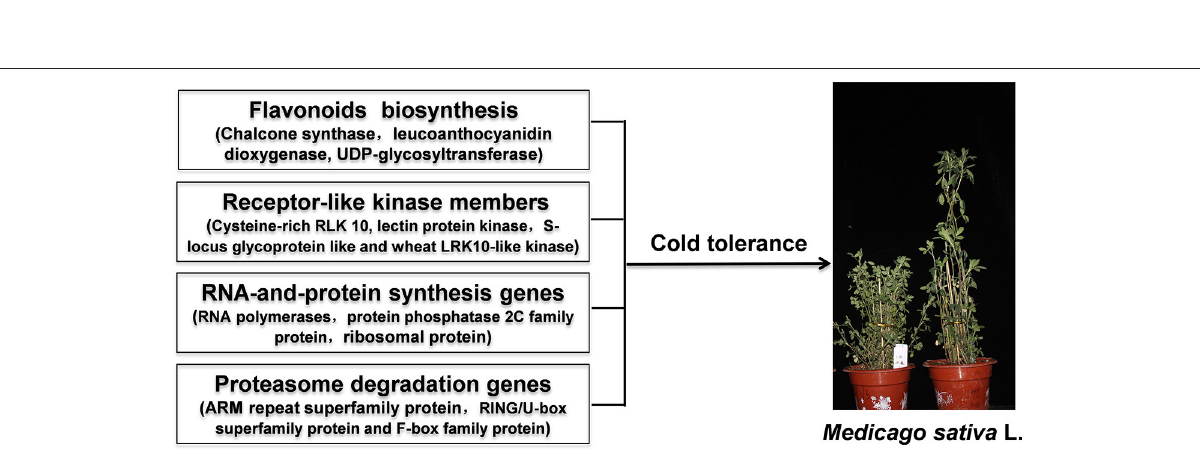
FIGURE 9 | Diagram of a proposed regulatory network for low temperature tolerance in